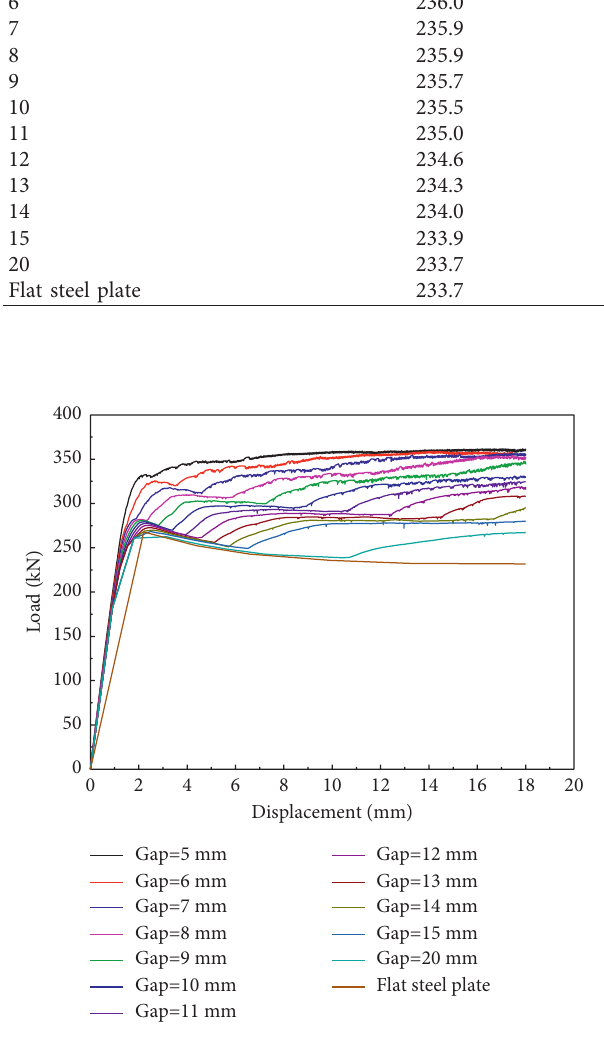
Figure 5: Load-displacement curves of the novel BRSPSW with different gap thicknesses and with the flat steel